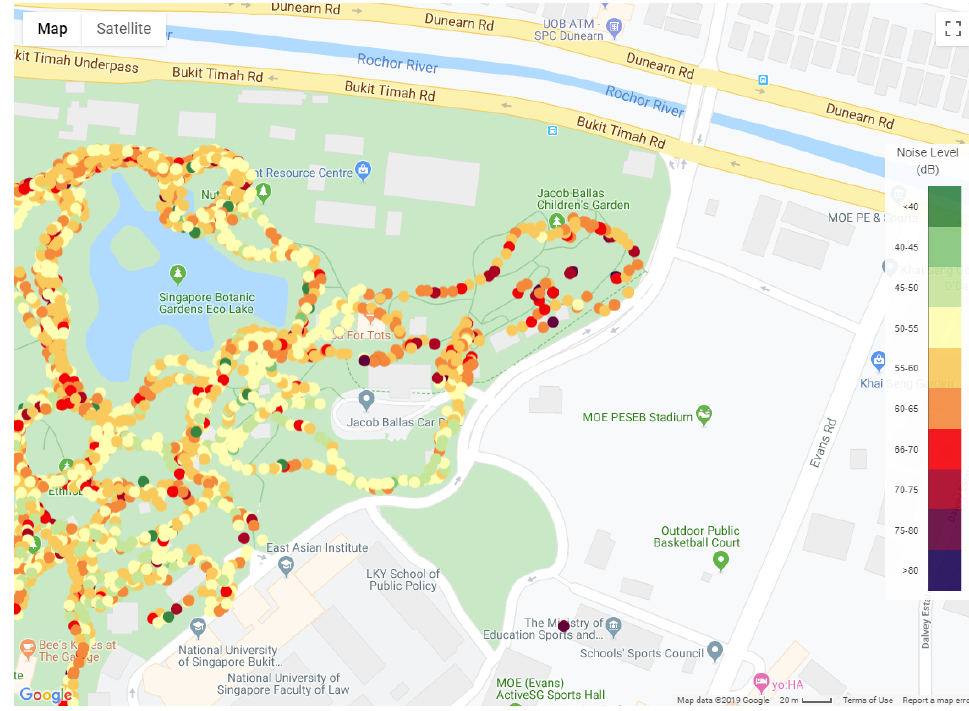
Figure 2: The noise map of the Jacob Ballas Children’s Garden (enlarged view of the top right-hand corner of Figure 1)